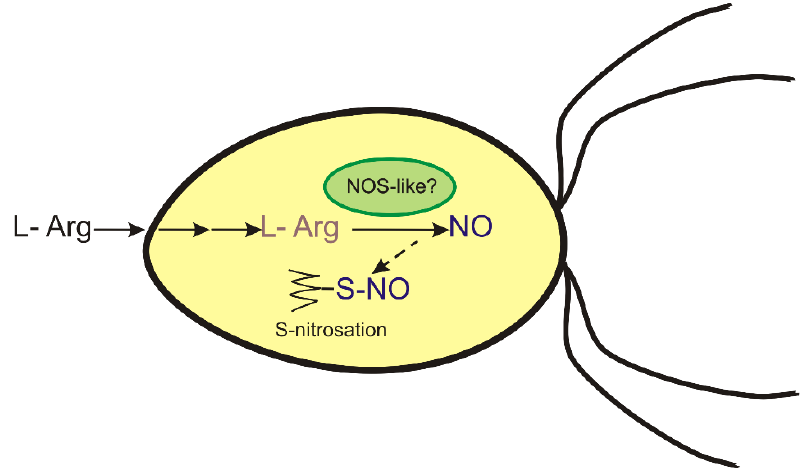
Figure 6. Working model for NO generation and NO signaling in P. parva . NO production can be achieved via an oxidative route from L-arginine. Subsequent NO signaling relies on NO-dependent post-translational modifications via